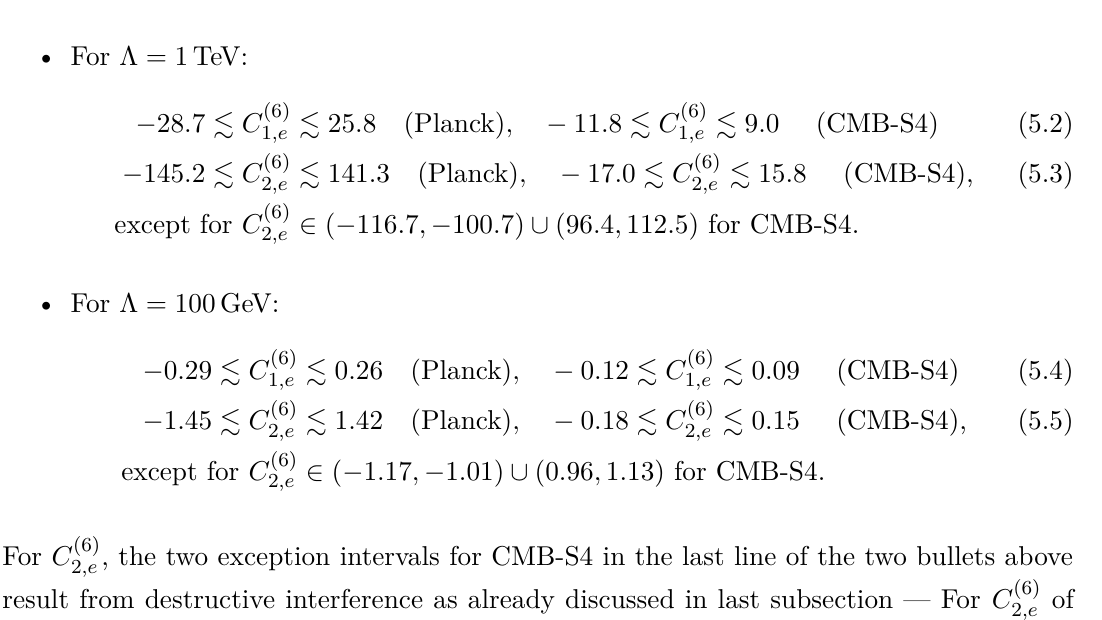
Figure 3 . Corrections to N eff from varying Wilson coefficients with Λ = 1 TeV and by considering only one non-vanishing NSI operator at a time. The upper left (right) panel corresponds to ∆ N from O (6) with Λ = 1000 GeV, and the lower left (right) panel is the same but with Λ = 100 GeV. 1(2) ,e The black curve stands for corrections to N from the NSI operator, and the horizontal colorful eff lines have the same meaning as those in figure 2. Note the scale difference of the horizontal axes and see more discussion in the main